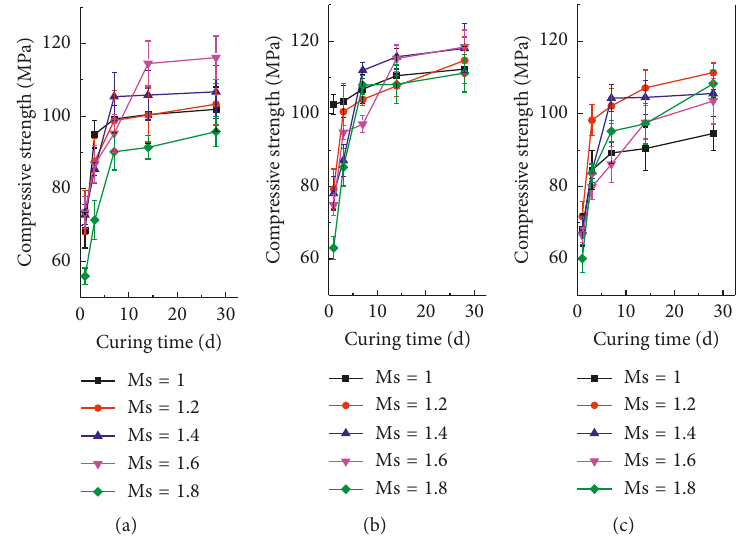
Figure 3: The effects of silicate moduli and Na 2 O contents on compressive strength of AAS pastes. (a) 6% Na 2 O. (b) 8% Na 2 O. (c) 10% Na 2